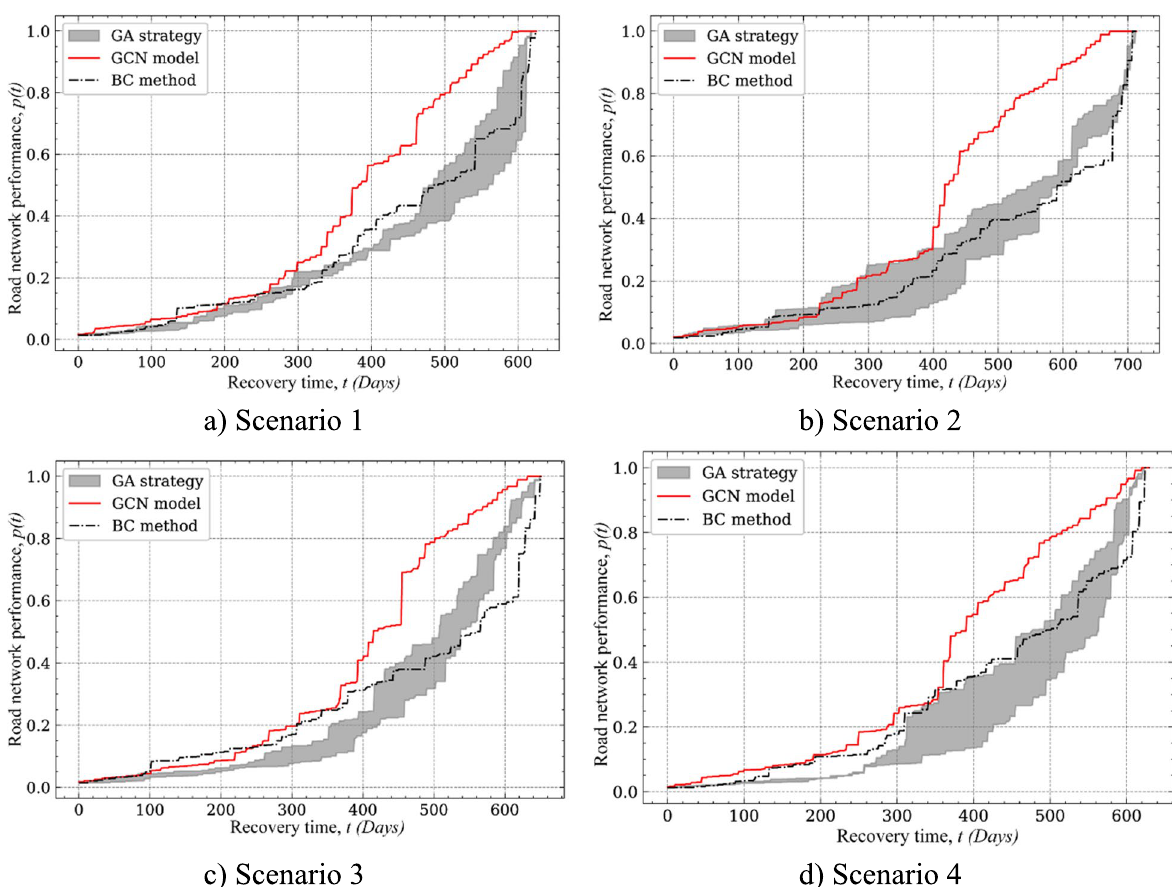
Fig. 11 Comparison of system recovery under different new damage scenarios based on repairing sequence determined by different decision methods (i.e., pre-trained GCN-DRL model, genetic algorithm, betweenness centrality)